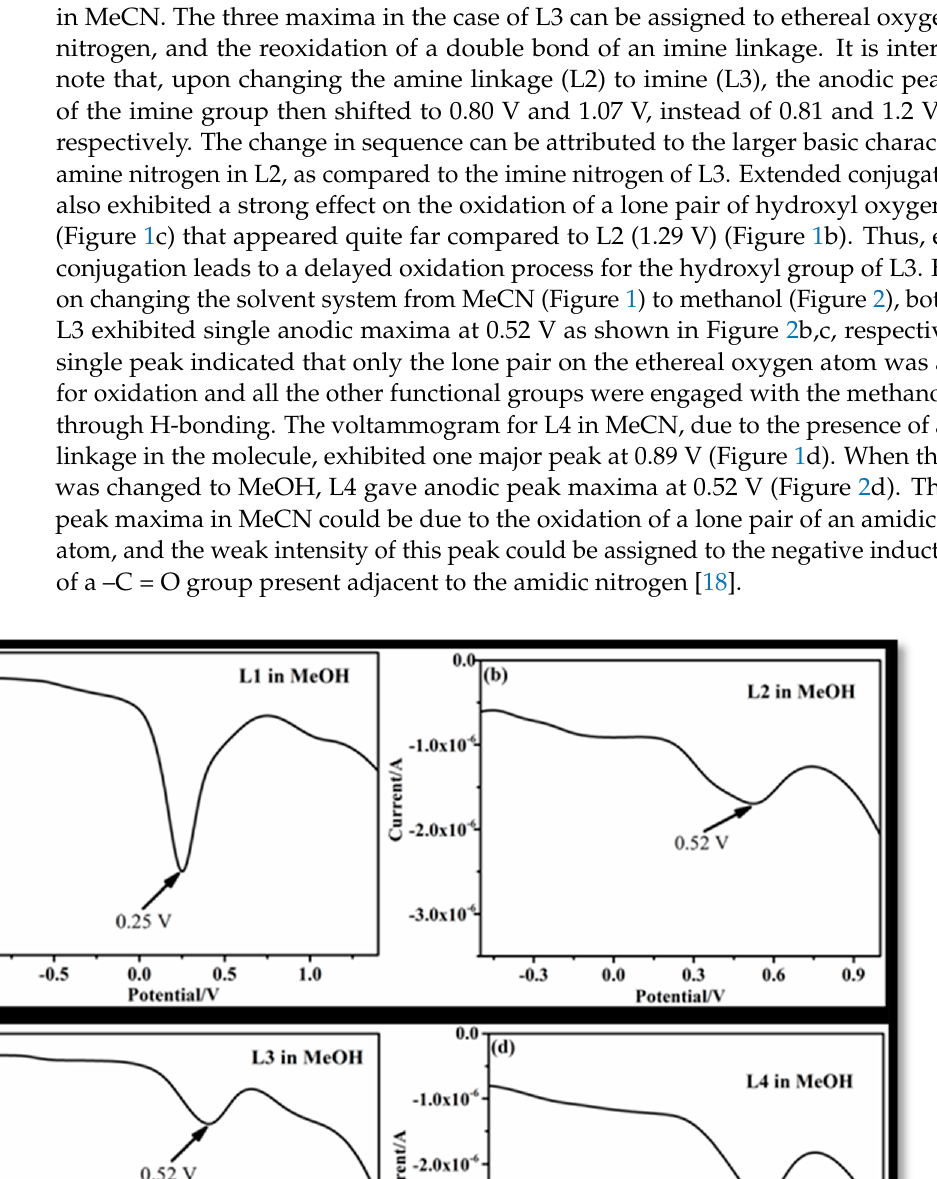
Figure 2. Anodic voltammogram of receptor L1 ( a ), L2 ( b ), L3 ( c ), and L4 ( d ) in MeOH medium.